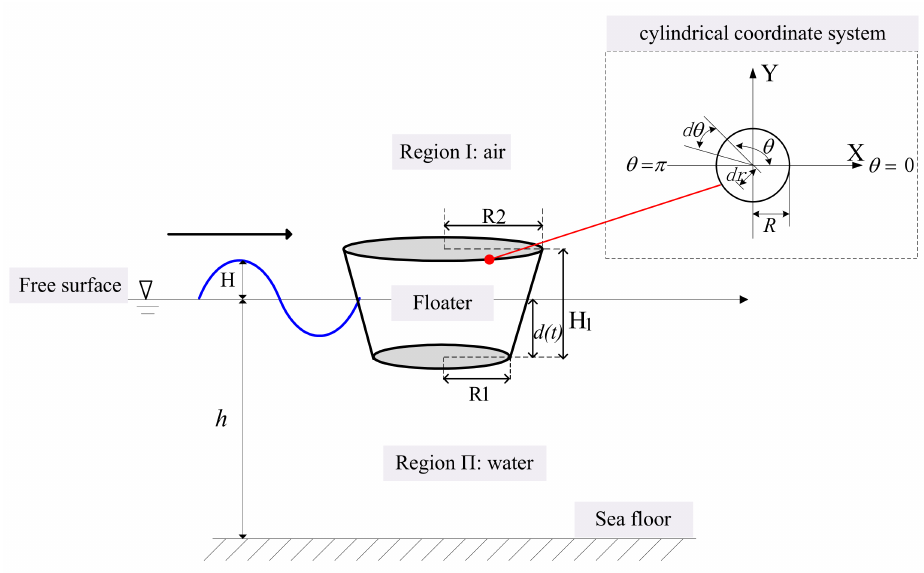
Figure 2. Cone frustum floater